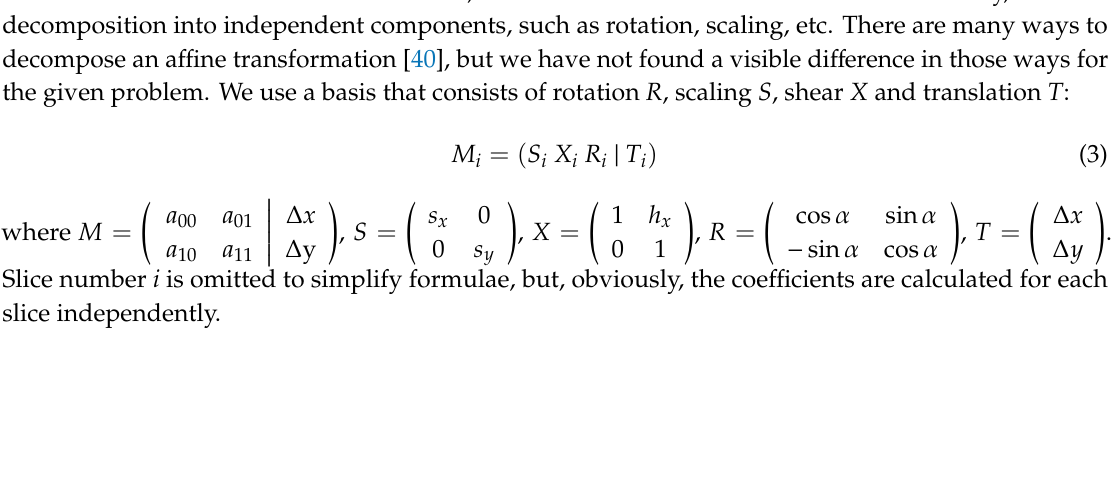
Figure 7. An example of smoothing of the initial signal and finding a high-frequency component.